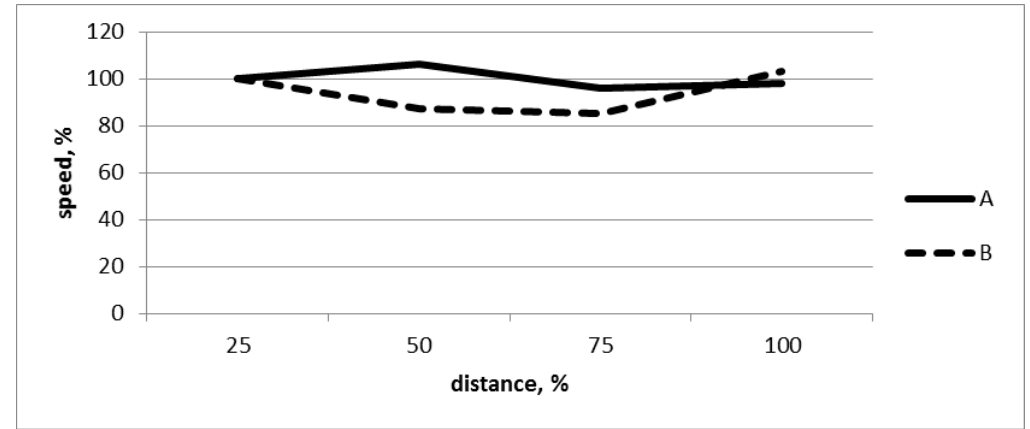
Figure. 1. Dynamics of speed of passing 4 km distance in various modes of muscular activity. Note: initial speed is considered as